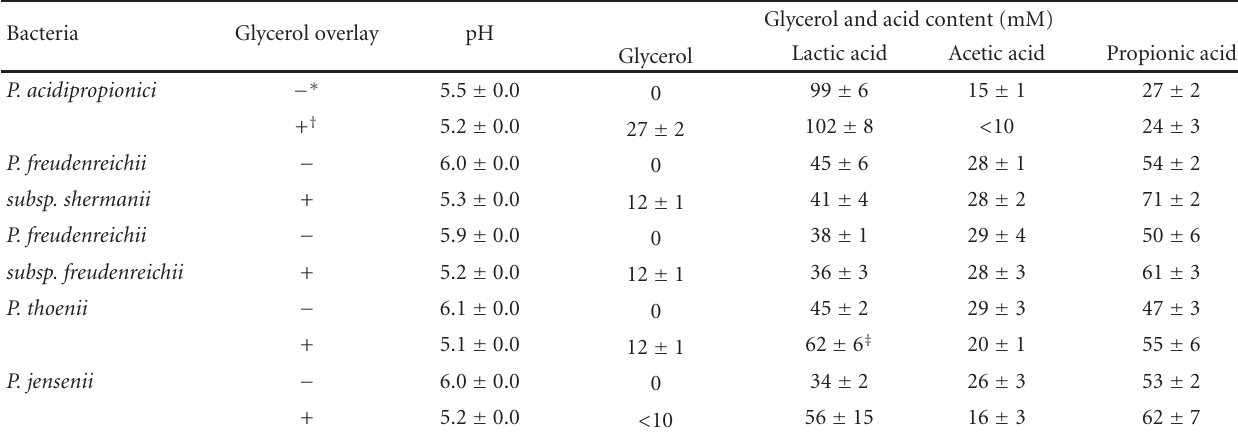
Table 1: pH and acid production by 5 type strains of propionibacteria after extraction from overlay assay plates. Data in the table show mean values with one standard deviation ( n = 4).